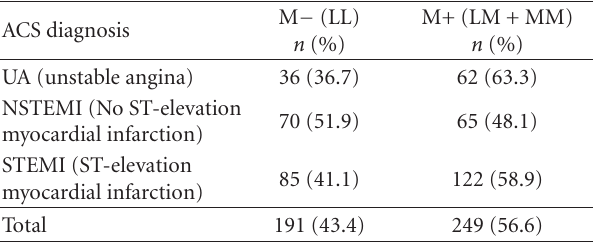
Table 2: PON1 55 carriers frequencies of 440 ACS